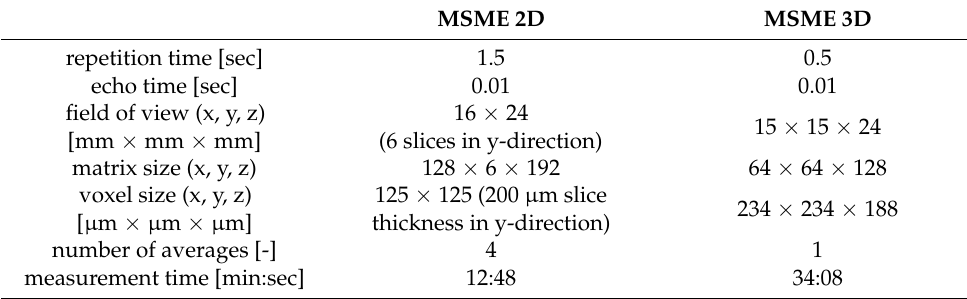
Table 1. Acquisition parameters of MRI